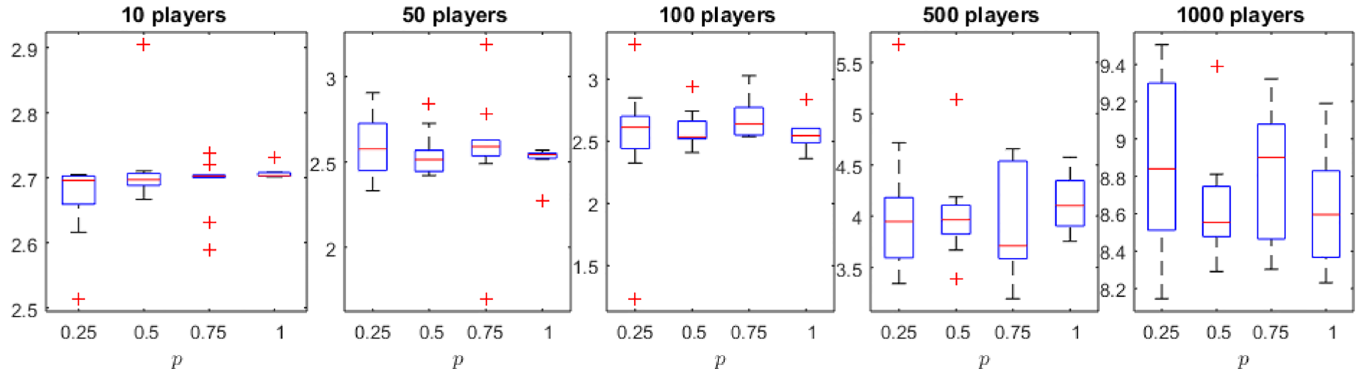
Fig 3. Distance to Nash equilibrium for the Cournot oligopoly and different p values. The null hypothesisthat there is no statistical difference between means of results could not be rejectedby using a Wilcoxon sum-rank test (0.05 significance level).